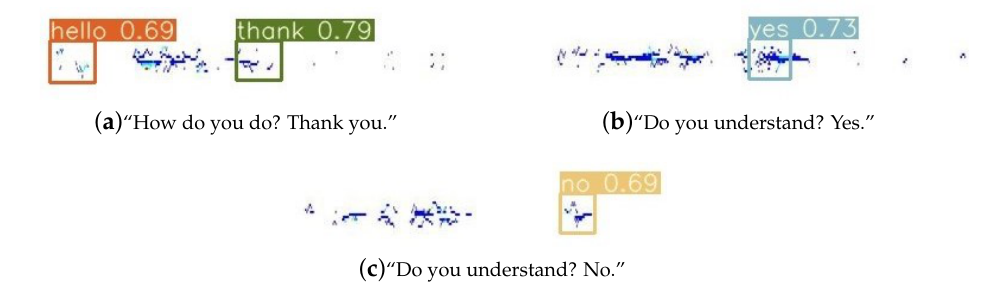
Figure 9. The predicted categories and confidence scores of dialogues. Table 5. The recognition results of three dialogues and word error rate (WER) comparison with other